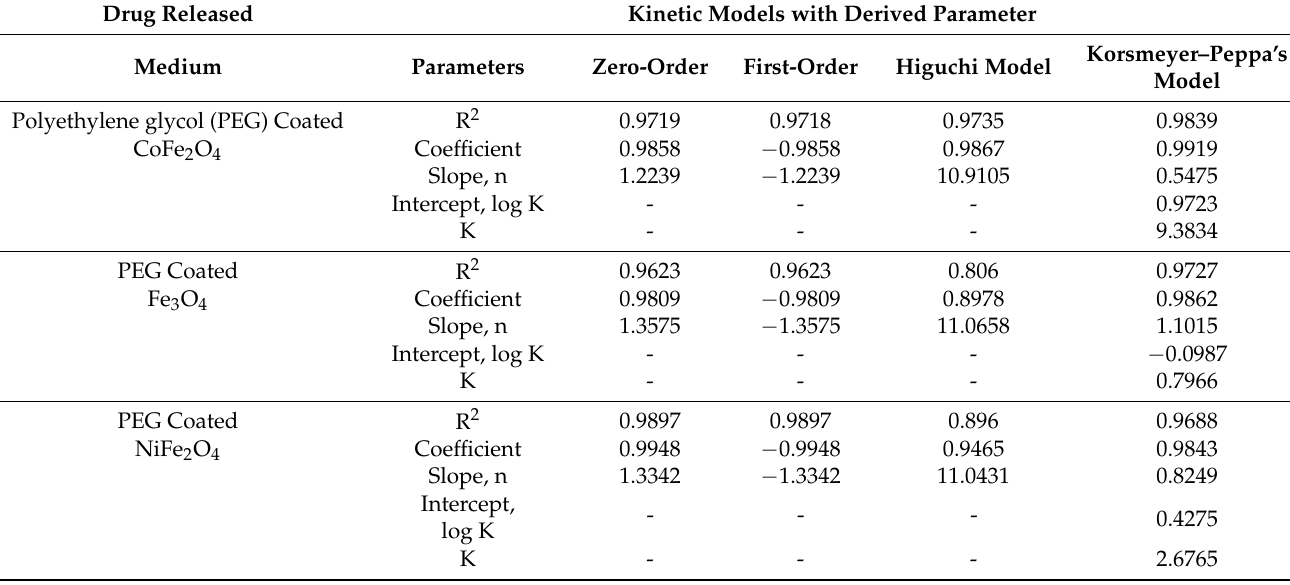
Figure 4. DOX release: ( a ) Zero-order, ( b ) First-order, ( c ) Higuchi and ( d ) Korsmeyer–Peppa’s kinetic model profiles of PEG Coated MNPs in PBS buffer solution. Table 1. R 2 values and derived parameters of the respective